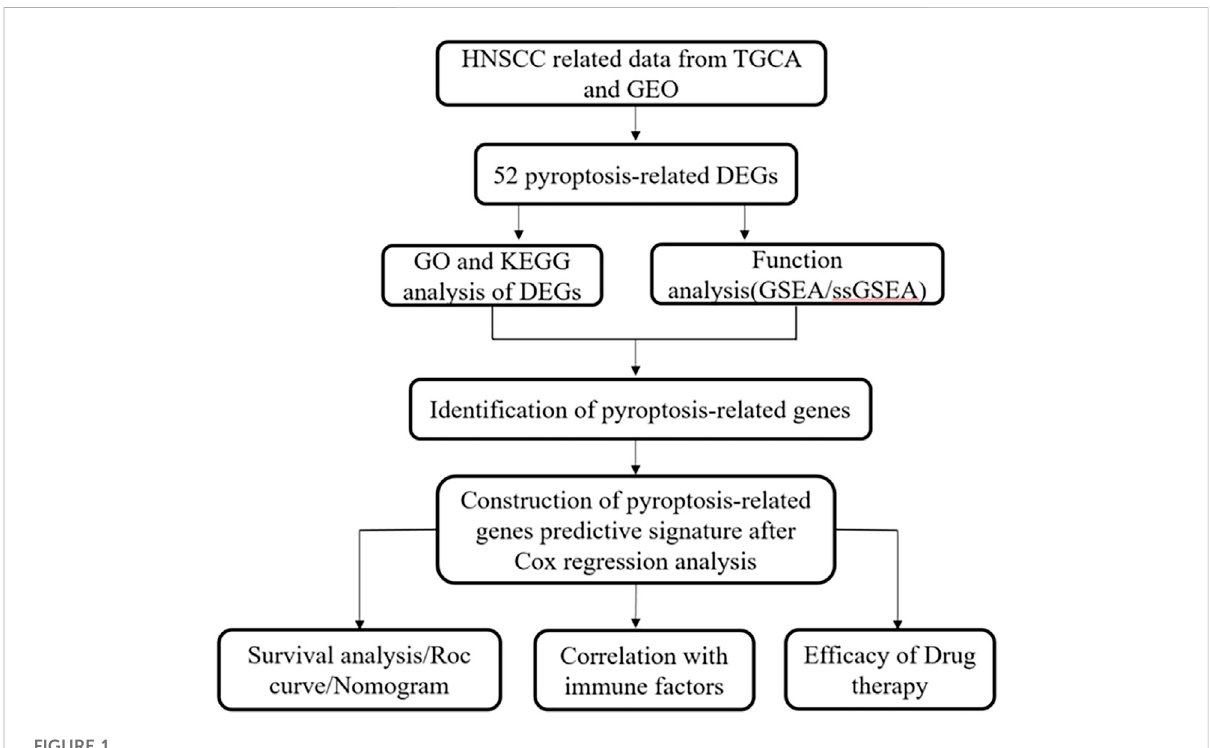
FIGURE 1 Study fl ow chart and